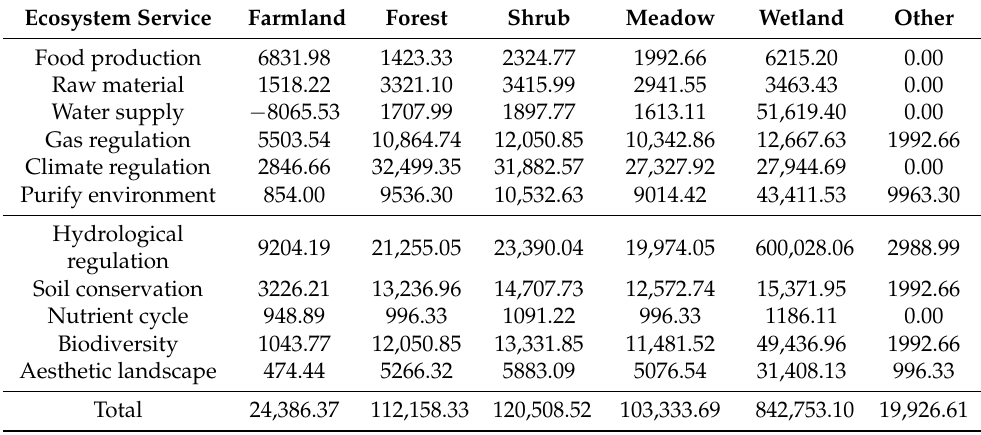
Table 6. The ESV per Unit Area of LULC in the SAHMHER. ( Ұ /hm 2 .a).